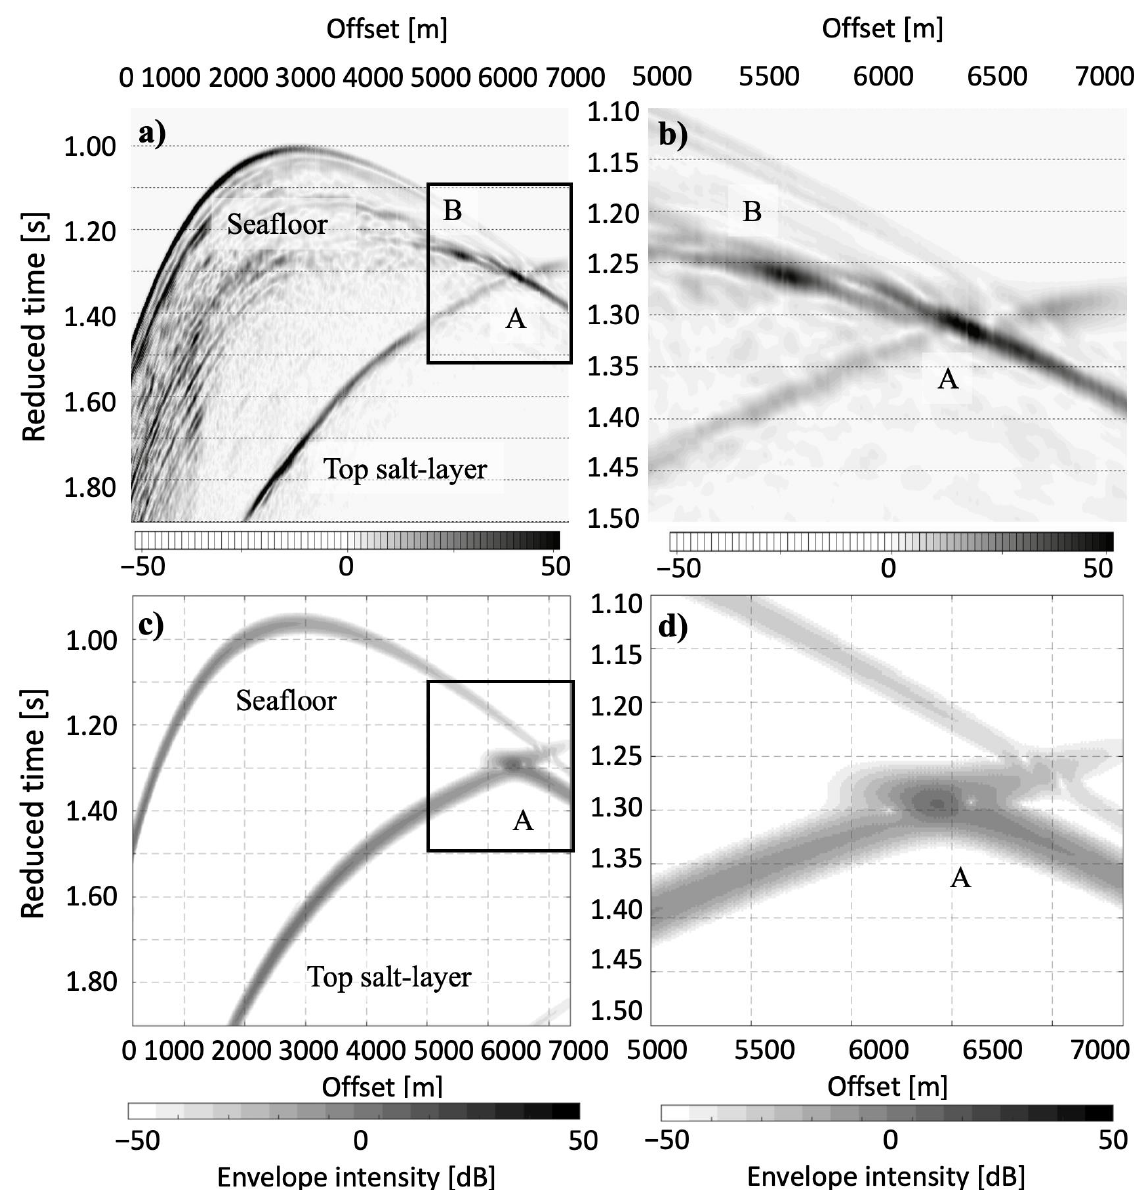
Figure 10. A reduced time vs offset plot of the amplitude envelope of the experimental source gather #2290 ( a ) and its zoomed portion ( b ); and the amplitude envelope of the simulated source gather #2290 for 𝑐 0 = 1525 m s − 1 , 𝐾 = 0.75, and 𝐻 2 = 1000 m ( c ), and its zoomed portion ( d ). The measured times are reduced with a velocity of 2000 m s −1 . A is a possible caustic that is found both in the experiment ( a , b ) and model ( c , d ) data. B is another arrival of strong intensity that can possibly be another caustic or a reflection from sub-bottom layering.